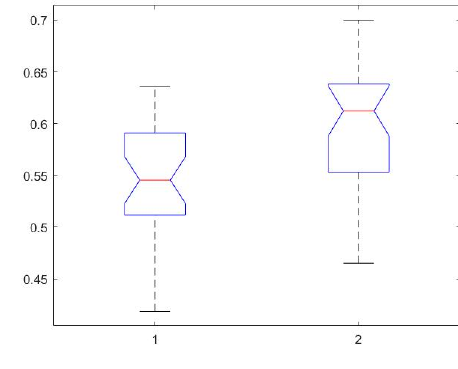
Figure 10. ANOVA test, F 1 indicator. 3. POCID indicator. The result indicates a dissimilarity between the POCID values, the one corresponding to the proposed method being significantly better.